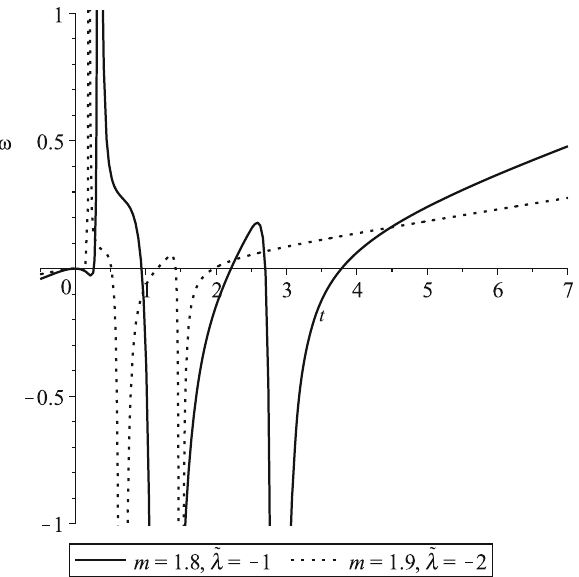
Fig. 7 Evolution of scalar field for Higgs–Starobinsky potential for different values of ˜ λ < 0 and m > 1